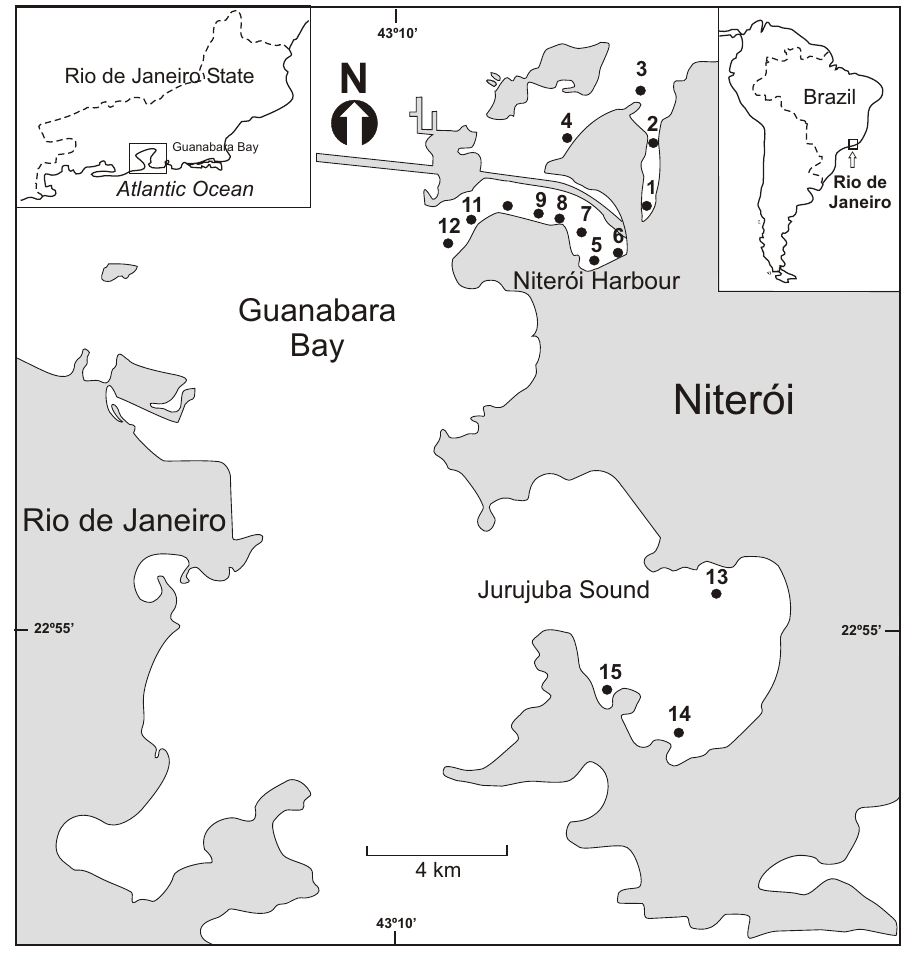
Fig. 1 – Location of the study area and sample stations collected in Niterói, Guanabara Bay, in June 2000.